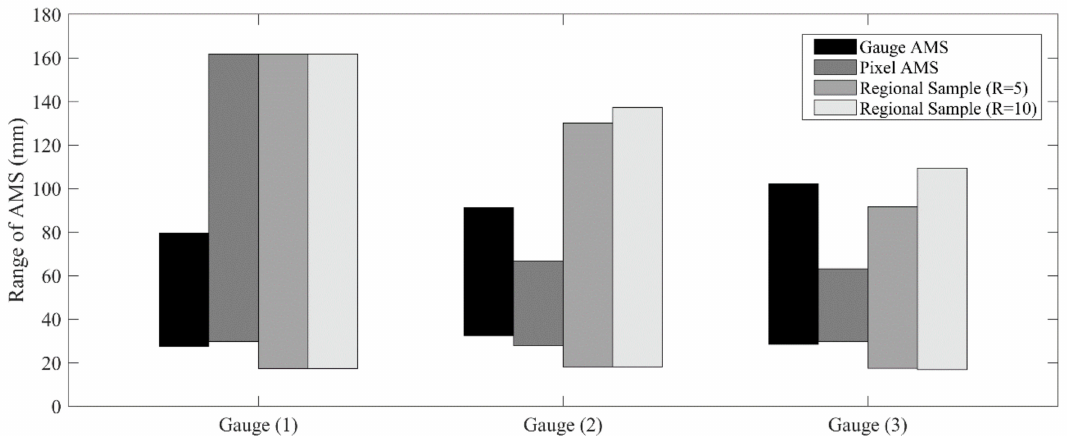
Figure 7. The range of AMS from gauge data, radar pixel, and radar-based regional sample considering a radius of 5 and 10 pixels. Each bar ranges between the minimum and maximum value in AMS sample extracted at the location of gauge (see Figure 1a for gauges locations).